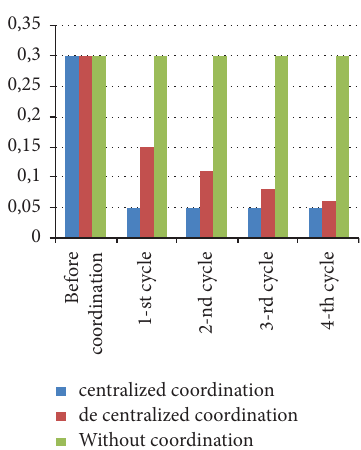
Figure 13: Comparison of the results of centralized and decen- tralized